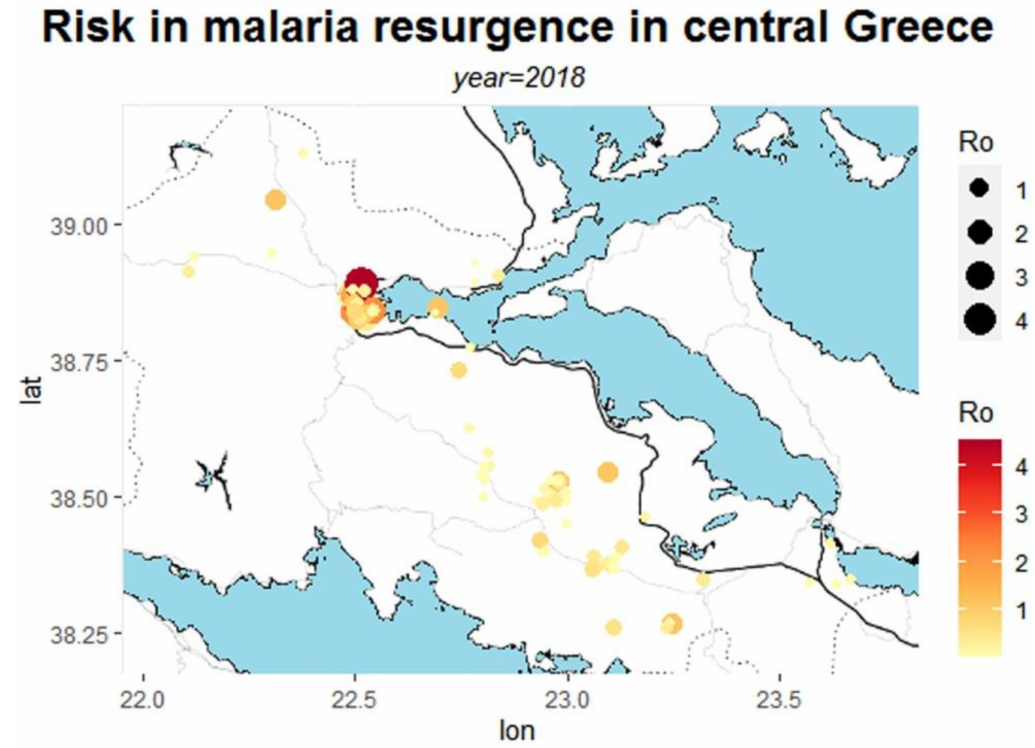
Figure A1. Point estimate map of risk of malaria transmission ( R 0